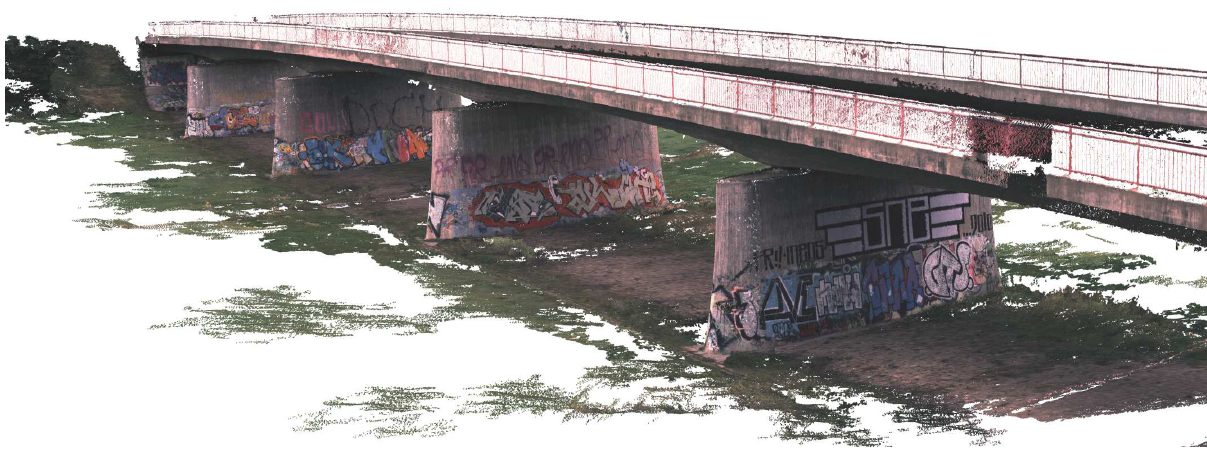
Figure 8: RGB-colored 3D point cloud from SfM.